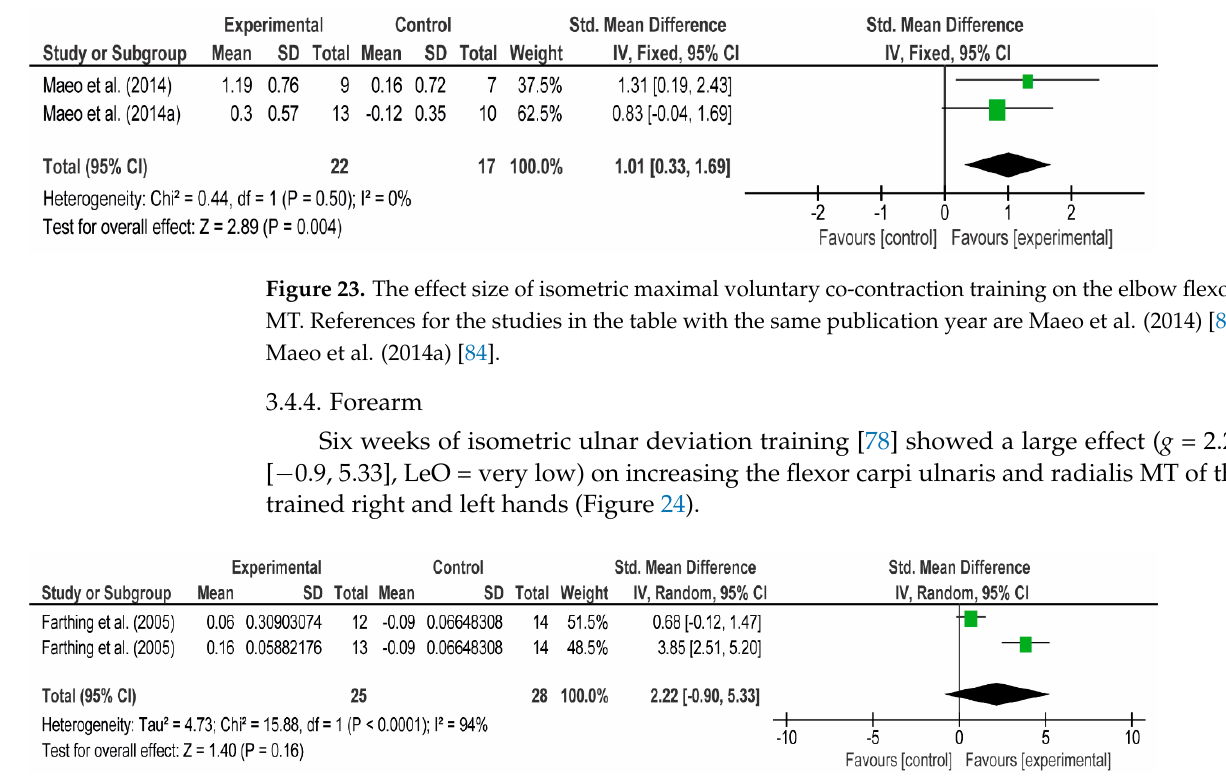
Figure 22. The effect size of 6 -weeks of heavy elbow flexion exercise on the elbow flexors’ MT. The